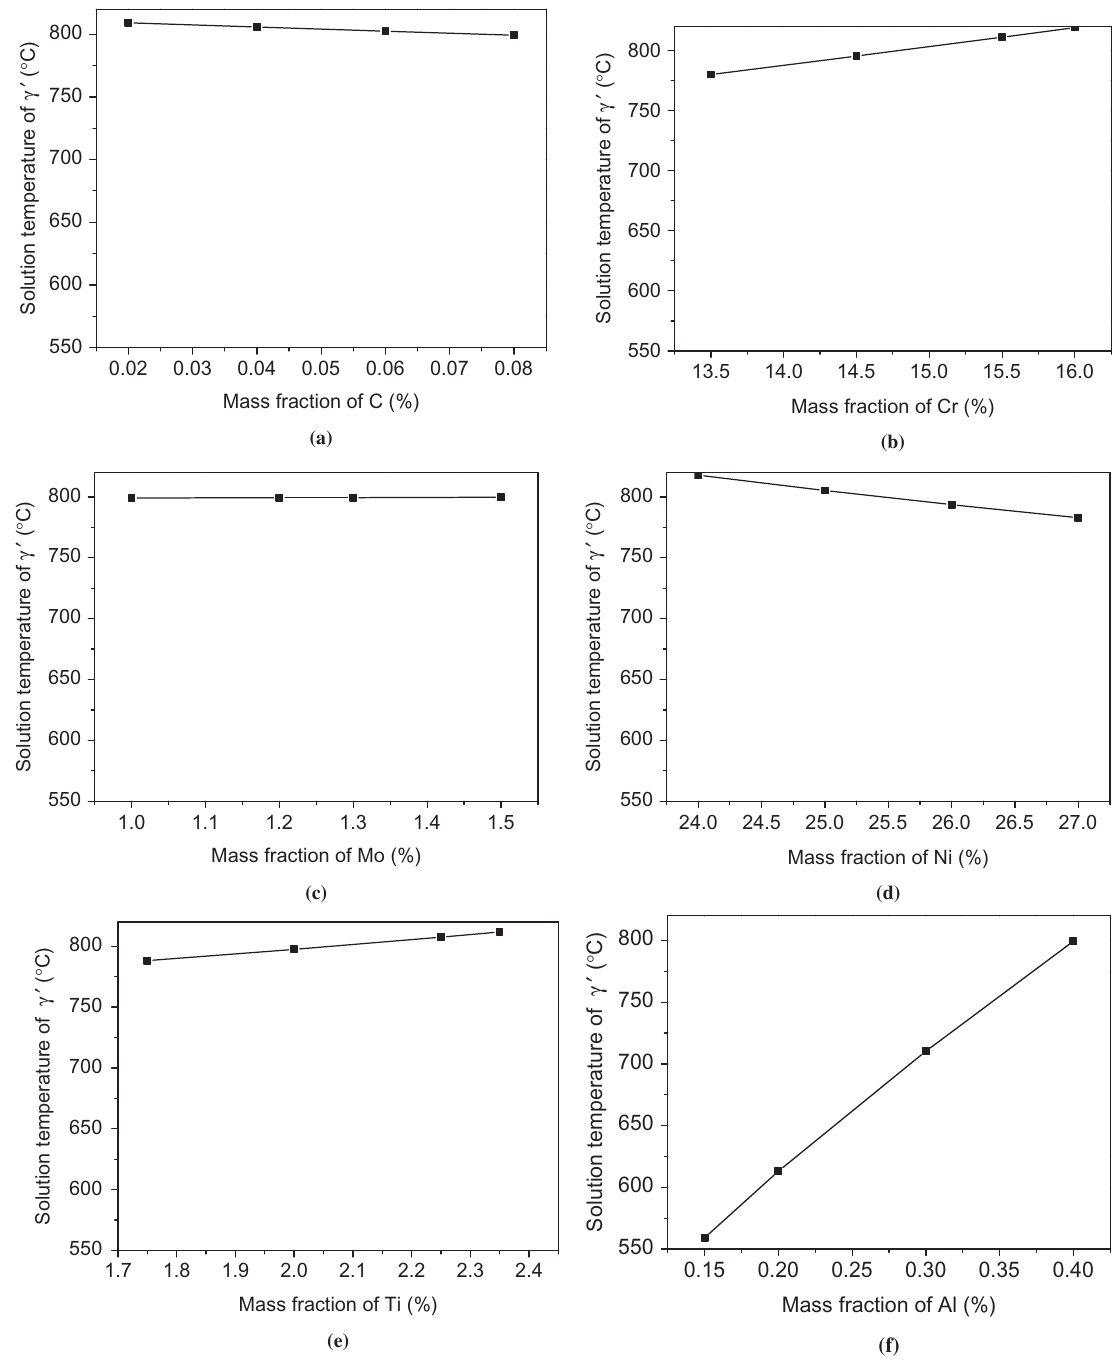
Figure 3: Variation of complete solution temperature of γ ′ phase with the contents of (a) C; (b) Cr; (c) Mo; (d) Ni; (e) Ti; (f)